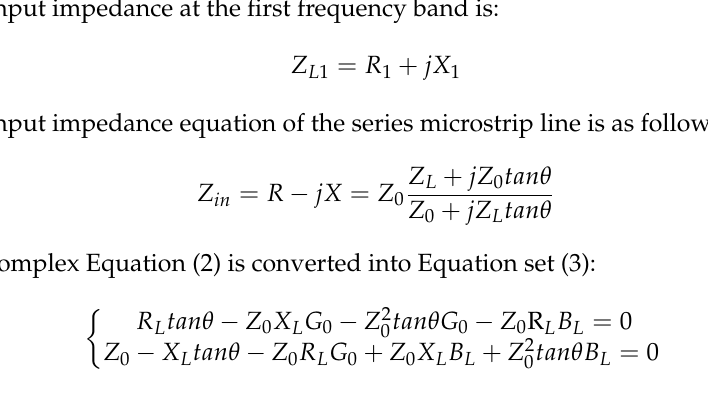
Figure 1. Match circuit structure diagram. * The default is 𝑍 (cid:2868) = 50Ω